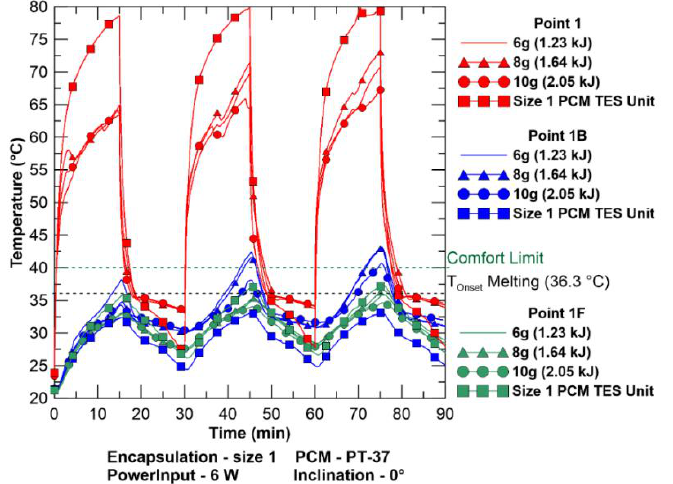
Figure 12. Comparison between Size 1 PT-37 TES unit with smaller PT-37 TES units having different latent heats at 6 W power input and 45° inclination: performance of the tablet PC.